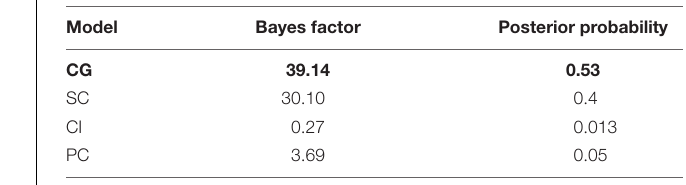
together, while four, seven, and two groups were recognized in Clades C, D, and E, respectively. bGMYC detected only nine groups that recovered Clades A, B, and E, while separating two and four groups in Clades C and D, respectively.